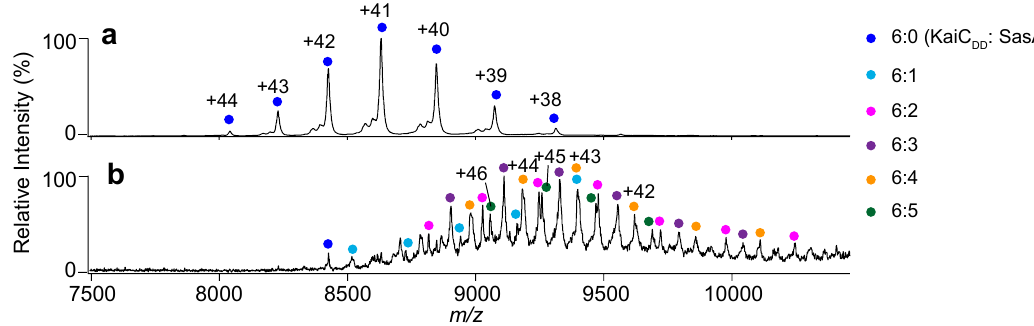
Figure 5. Native MS analysis of TeKaiC DD –TeSasA N complex formation. Mass spectra of mixtures of TeKaiC DD and TeSasA N at ( a ) 1:0 and ( b ) 1:3.5 molar ratios (TeKaiC DD to TeSasA N ). The blue, cyan, magenta, purple, orange, and green circles show the ion series of the TeKaiC DD homohexamer and 6:1, 6:2, 6:3, 6:4, and 6:5 complexes of TeKaiC DD and TeSasA N , respectively.